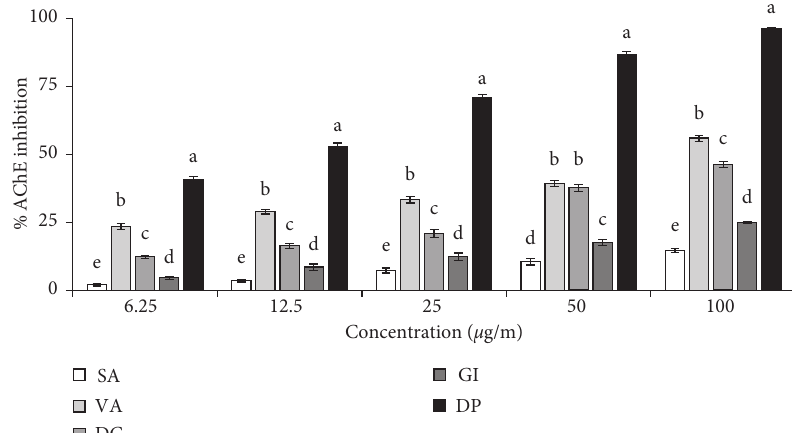
Figure 2: Inhibition of acetylcholinesterase activity by the isolated compounds. IC 50 ( μ g/ml): SA, 1268.33 ± 19.14; VA, 84.66 ± 3.20; DC, 118.17 ± 5.06; GI, 547.37 ± 11.47; DP, 10.11 ± 0.26. Results represent mean ± SD ( n � 3). Donepezil (DP) was used as a reference compound. Compound 1 had no activity and was not shown. Means with different letters (a–e) differ significantly ( P < 0 . 05). SA, syringaldehyde; VA, vanillin; DC, dihydroconiferyl dihydro- p -coumarate; GI, gigantol; DP, donepezil.